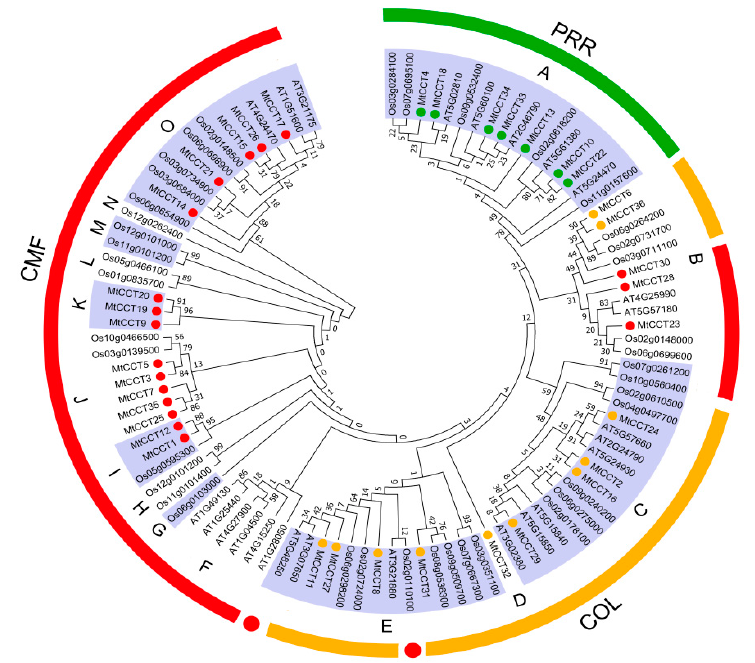
Figure 3. Phylogenetic relationships among CCT genes in M. truncatula , Arabidopsis and rice. The phylogenetic tree was constructed using MEGA (Molecular Evolutionary Genetics Analysis) 7 based on (ML, Maximum Likelihood) method; bootstrap was 1000 replicates. The different colored circles indicate proteins of different subfamilies.